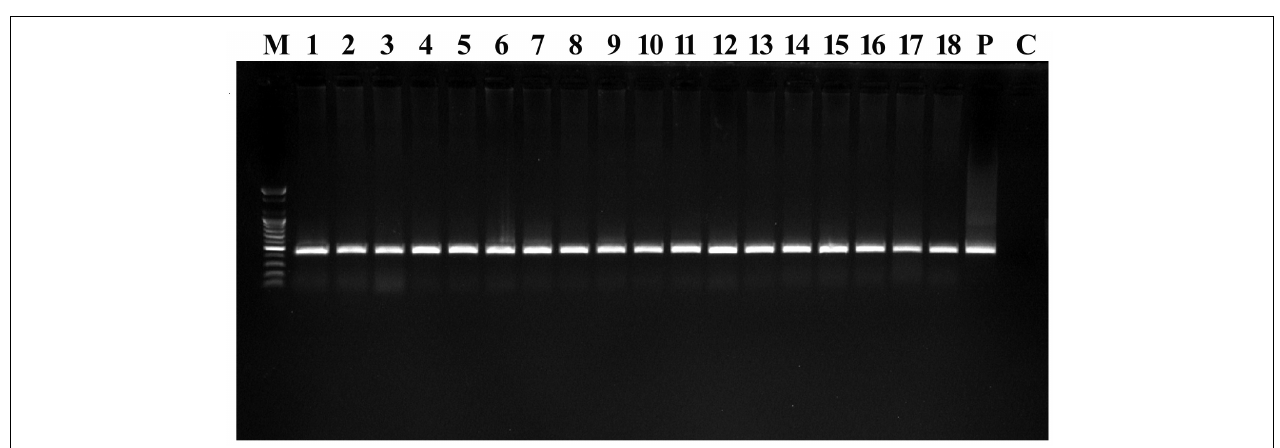
FIGURE 4 | PCR confirmation in T 0 transgenic Chinese cabbage plants. PCR amplification of 407-bp fragment of the hptII gene. Lane M 100-bp marker, lanes 1–18 DNA from transformed plants, lane P plasmid DNA (pCAMBIA1303; positive control), Lane C non-transformed plant DNA (negative